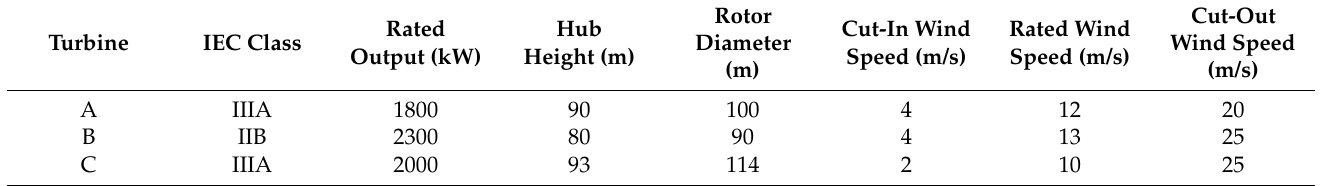
Table 1. Technical specifications of selected wind